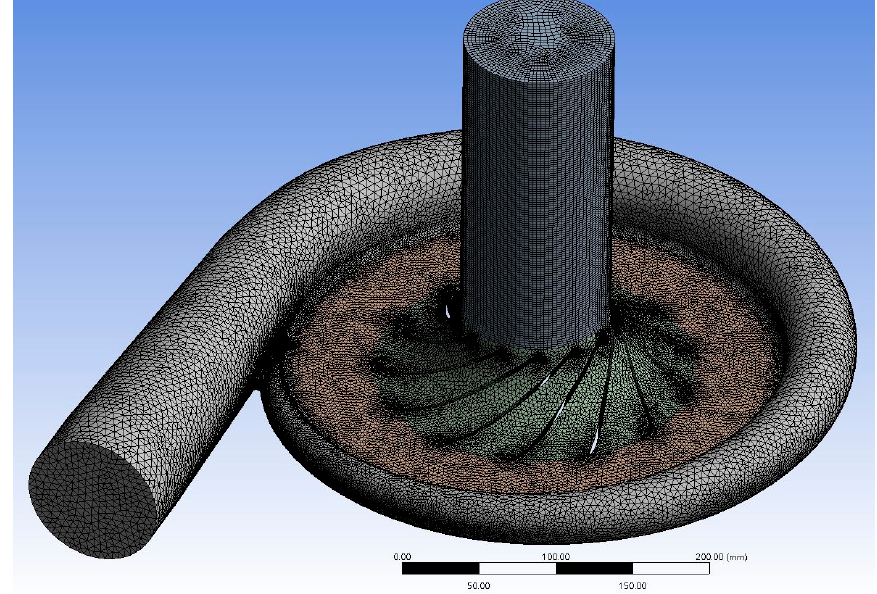
Figure 5. Global diagrams of compressor model meshes.